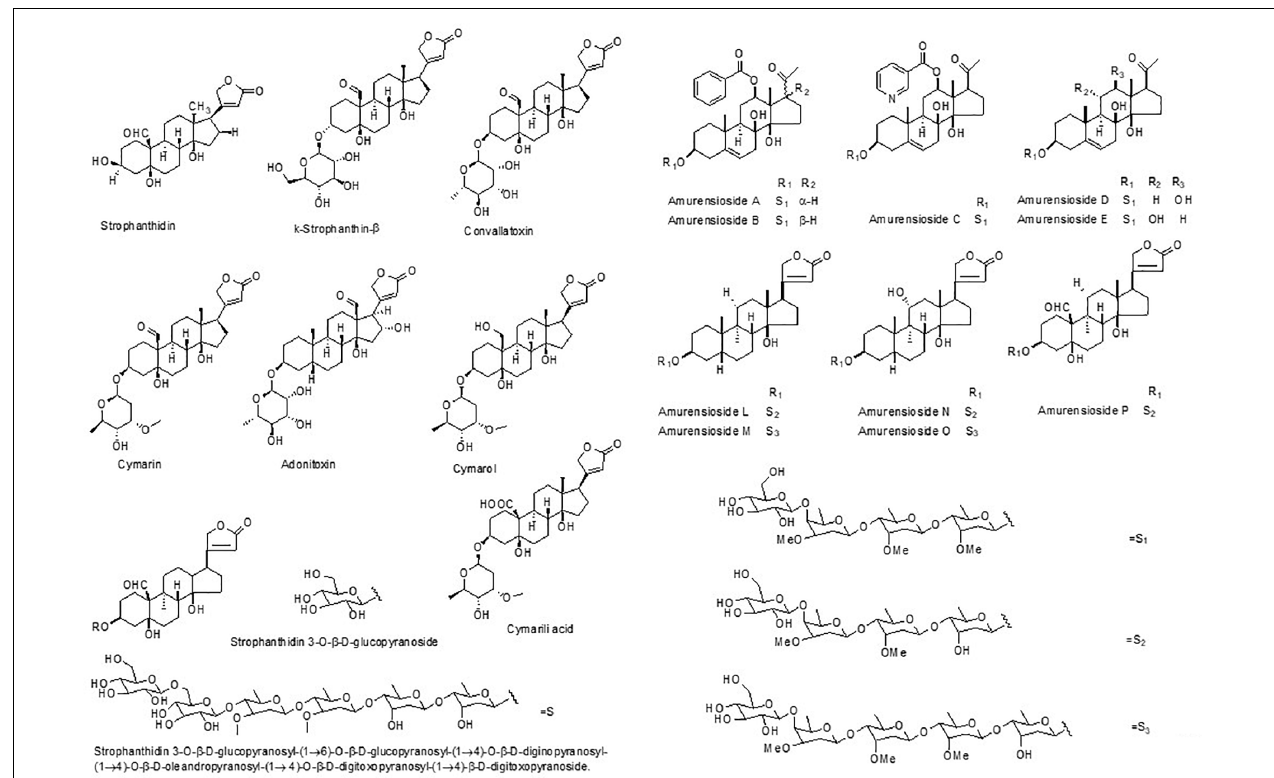
FIGURE 2 | The chemical structure of some active compounds from the genus